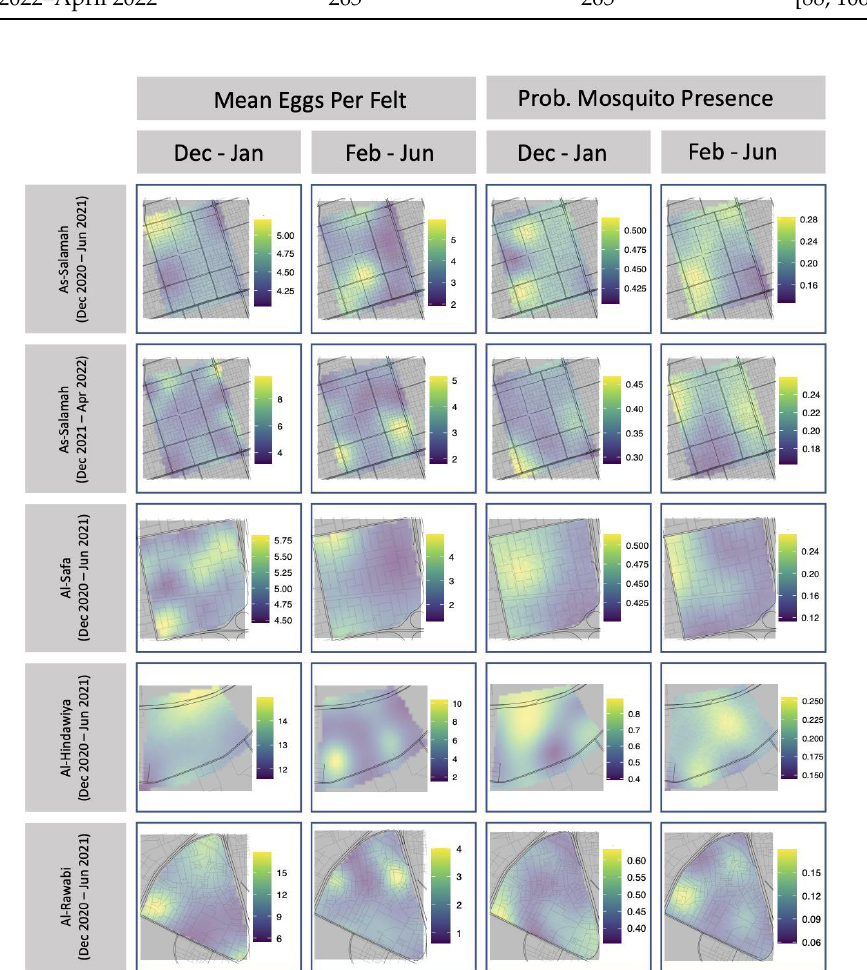
Figure 5. Estimated spatial fields for mean number of eggs per felt and probability of mosquito presence for ovitrap felts collected in each of the four study